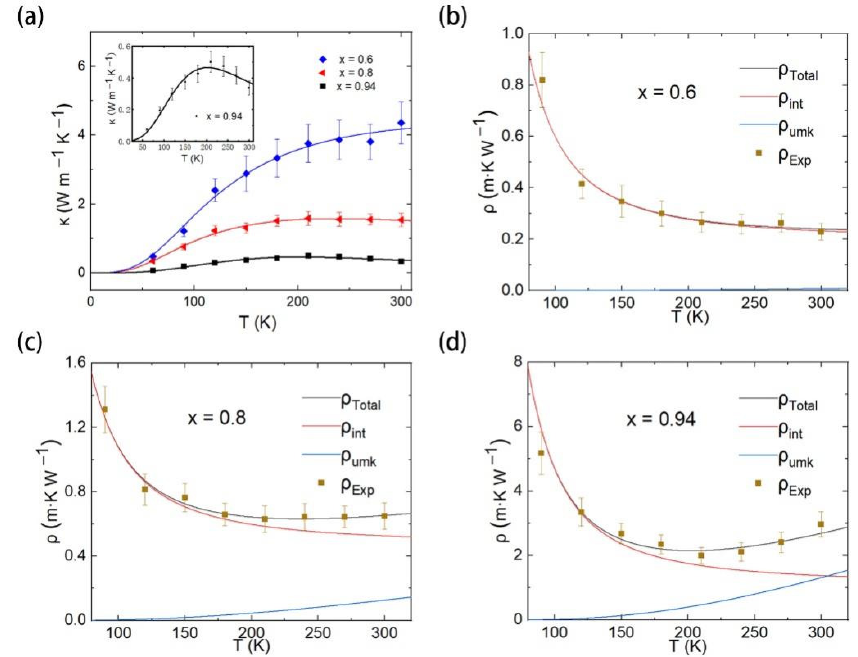
Figure 6. ( a ) Fittings of experimental thermoconductivities of single (CuCr 2 Se 4 ) 1 − x (CuCrSe 2 ) x (x = 0.94, 0.8, 0.6) crystals by the Debye − Callaway model. Inset is the enlarged data of (CuCr 2 Se 4 ) 0.06 (CuCrSe 2 ) 0.94 . ( b – d ) Relative contribution of three-phonon Umklapp scattering and interfacial scattering to thermal resistivity in (CuCr 2 Se 4 ) 1 − x (CuCrSe 2 ) x (x = 0.94, 0.8, 0.6). Table 1. The parameters in fitting thermal conductivity of samples by the Debye-Callaway model. L (nm) B (s/K) θ D (K) (CuCr 2 Se 4 ) 0.4 (CuCrSe 2 ) 0.6 0.58 (CuCr 2 Se 4 ) 0.2 (CuCrSe 2 ) 0.8 (CuCr 2 Se 4 ) 0.06 (CuCrSe 2 )